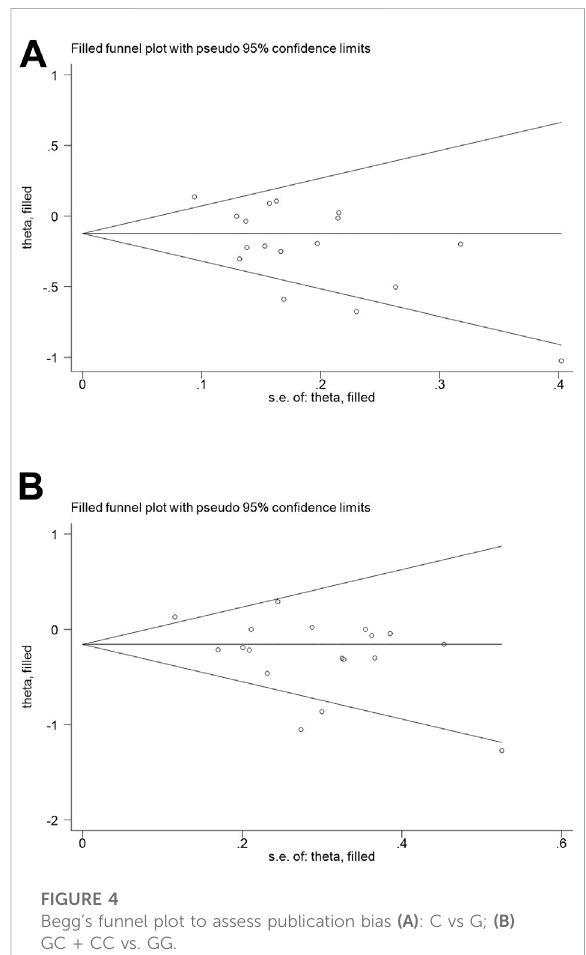
FIGURE 4 Begg ’ s funnel plot to assess publication bias (A) : C vs G; (B) GC + CC vs.